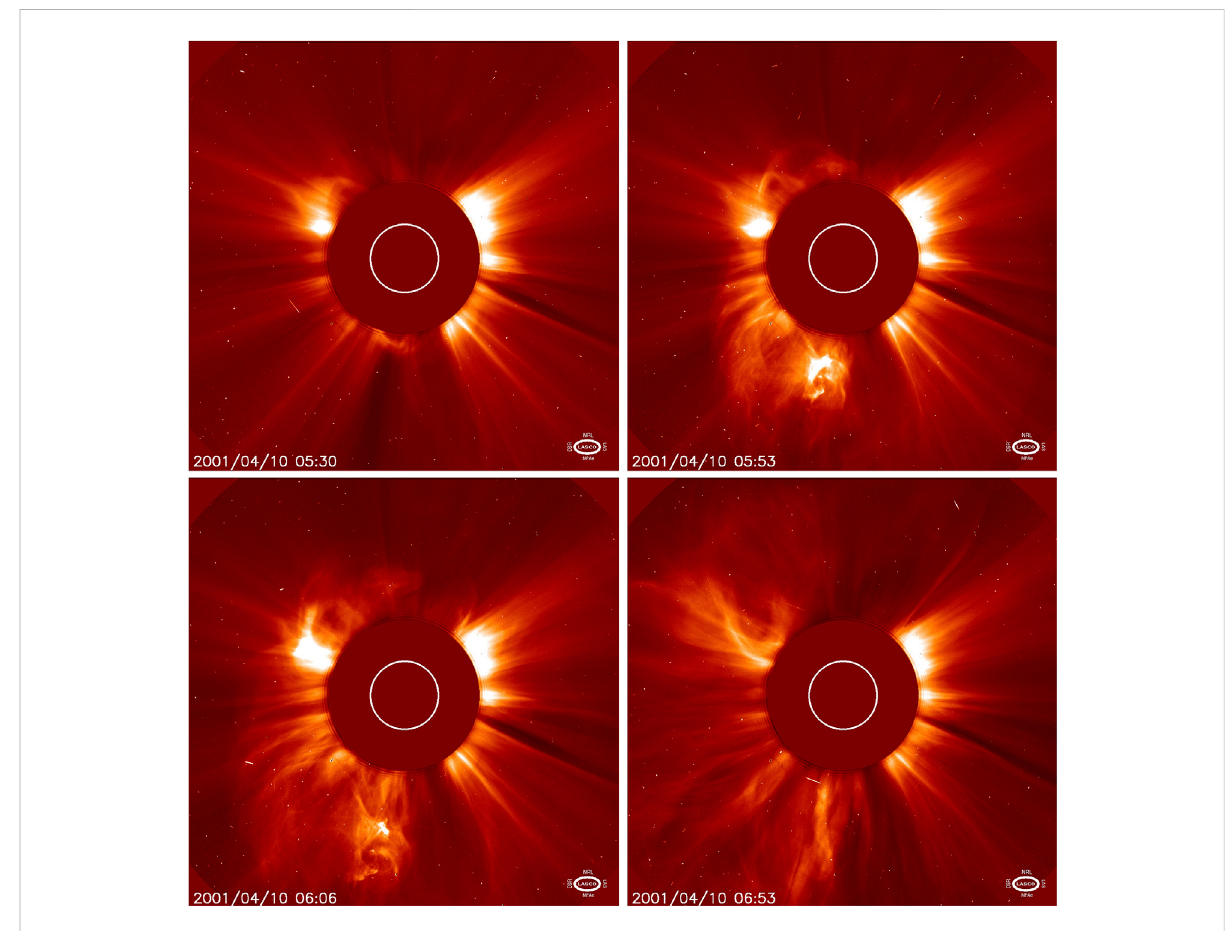
FIGURE 1 Time evolution of a CME, which occurred on 10 April 2001. Images were taken from